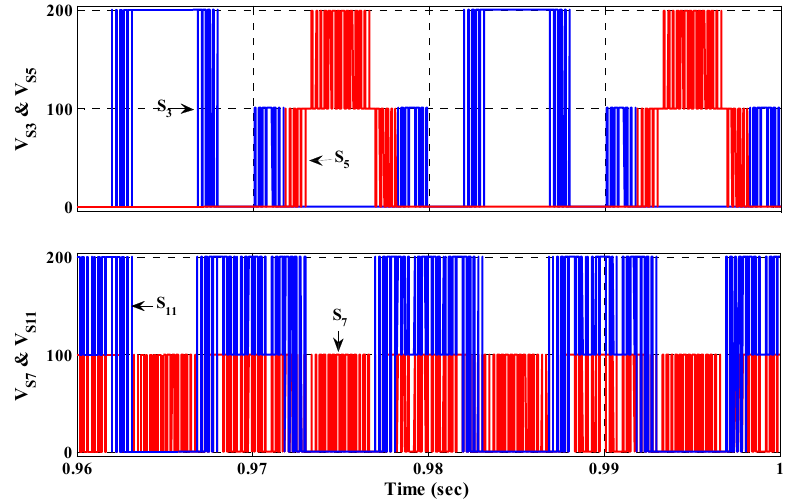
Figure 9. Voltages across the switches.